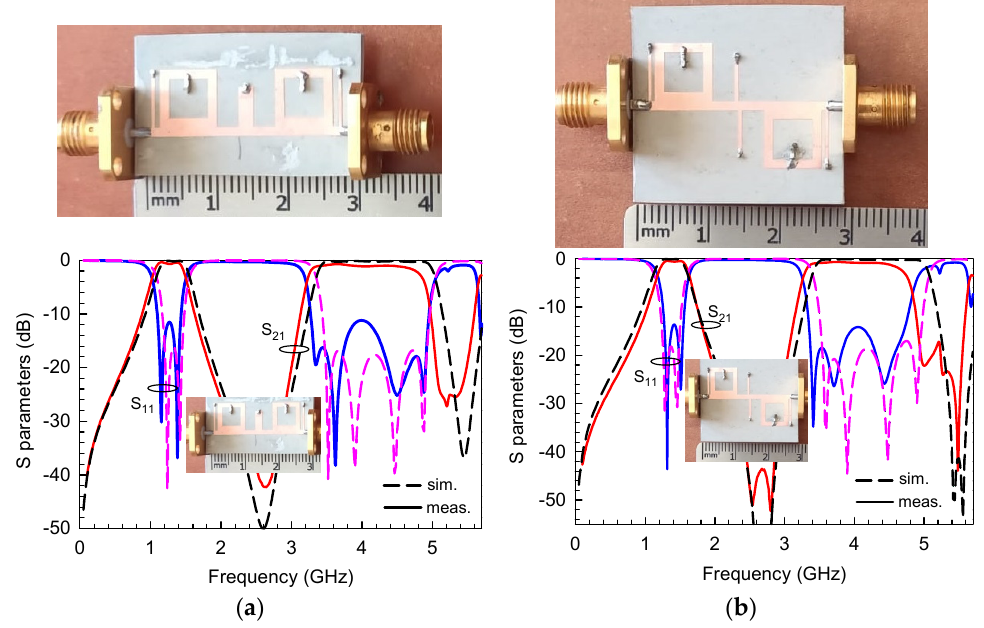
( b ) Figure 17. Bandwidth control of both passbands according to changes in ( a ) l s12 = l s21 , ( b ) d l12 = d l21 . 5. Experimental Study Two-band bandpass filter prototypes have been fabricated on a Rogers RT6010LM substrate with a thickness of 1.27 mm and a relative dielectric constant of 10.2 for valida-